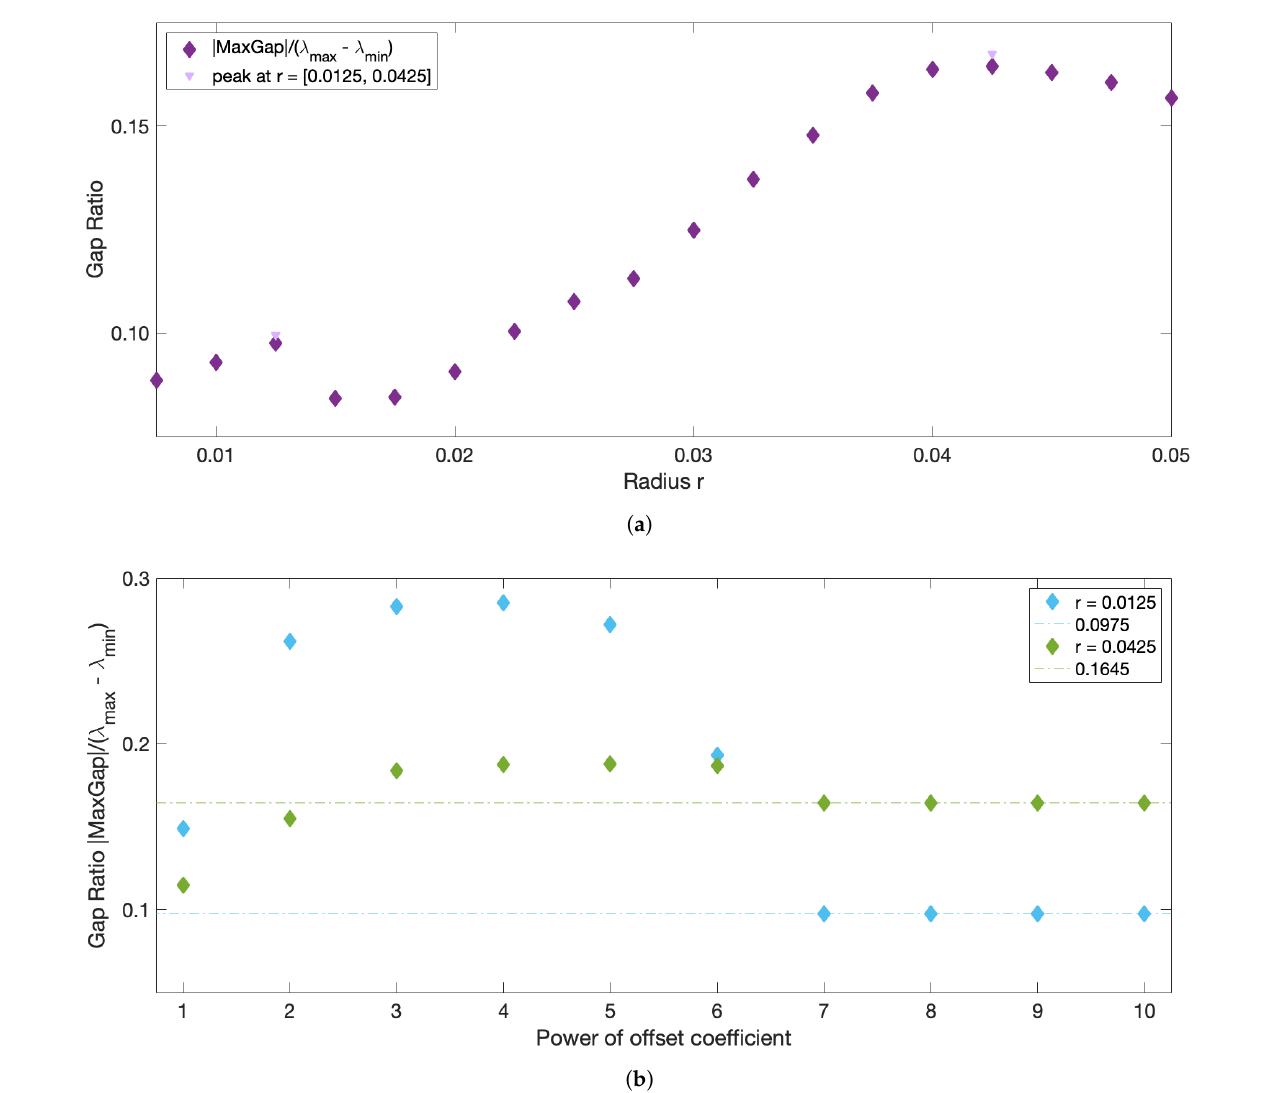
Figure A3. Steps 1 and 2 of the spectral clustering protocol for the 2017 No Man’s Land experiment for the 15:51–21:51 window. ( a ) Sweep of r parameters with offset coefficient 10 7 for the average distance function. ( b ) Sweep of offset coefficients 10 n for average distance function and the normalized eigengap peaks in ( a